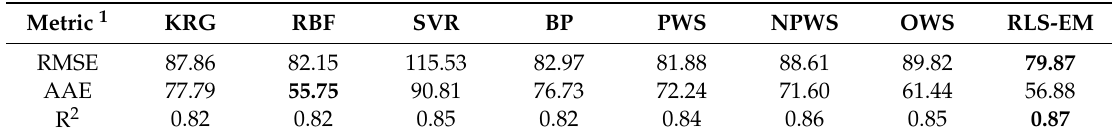
Table 4. Comparison for the design of milling machine bed.